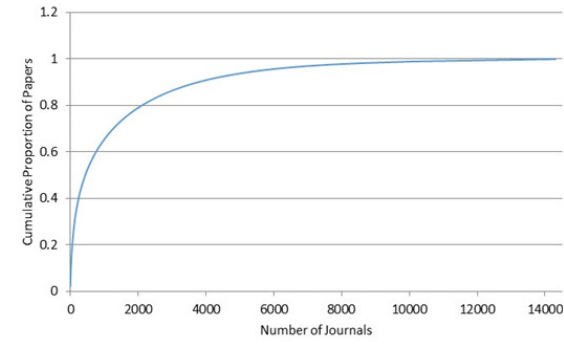
Figure 1. Cumulative proportion of papers per journal by Brazilian authors (Incites ® 2009-1019).